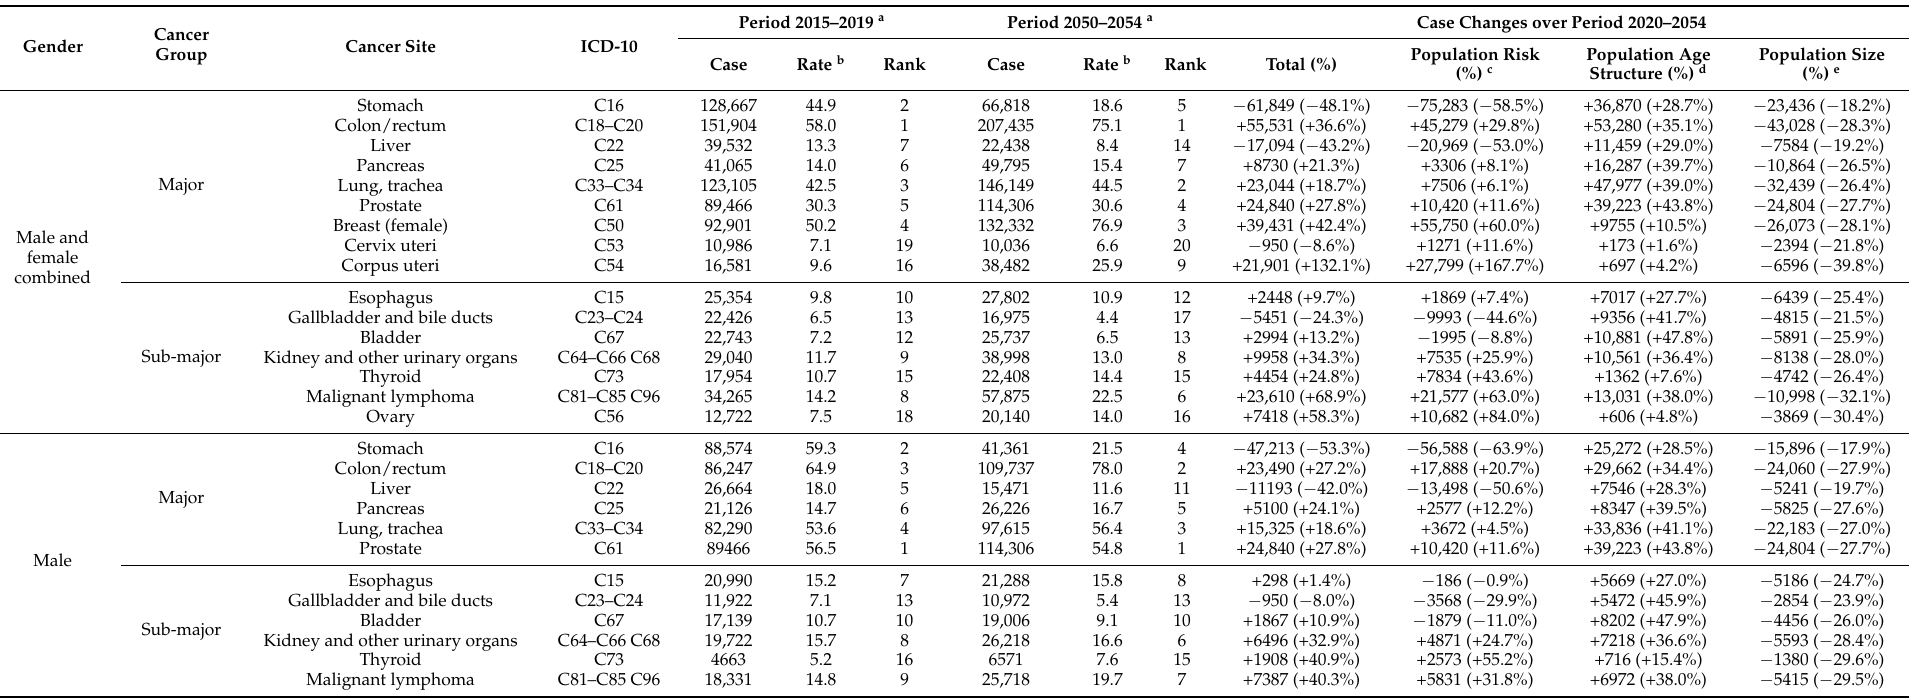
Table 2. Site-specific cancer incidence by gender and decomposition of case changes 2020–2054 for major and sub-major